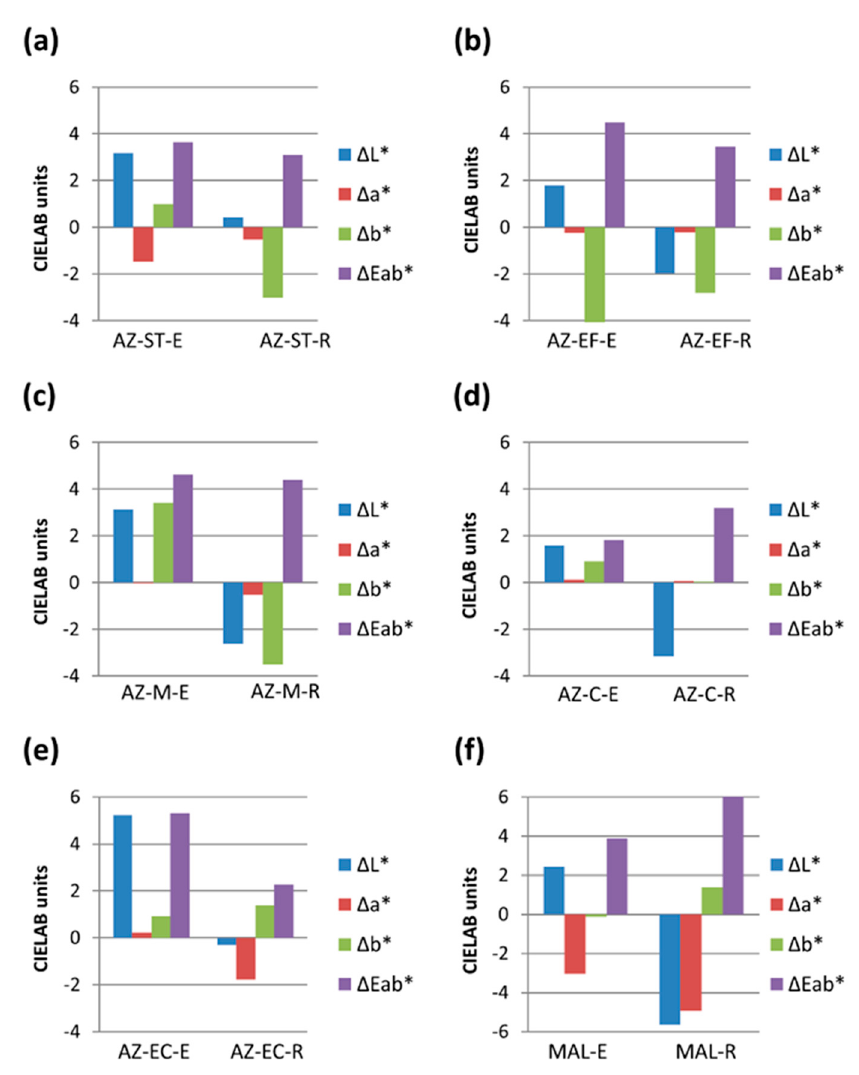
Figure 3. Color parameters variations ( ∆ L*, ∆ a*, and ∆ b*) and global color change ( ∆ E* ab ) of paint mock-ups after SO 2 exposure. ( a ) AZ-ST-based paints; ( b ) AZ-EF-based paints; ( c ) AZ-M-based paints; ( d ) AZ-C-based paints; ( e ) AZ-EC-based paints; ( f ) MAL-based paints. See Table 1 for more information about the paint labeling